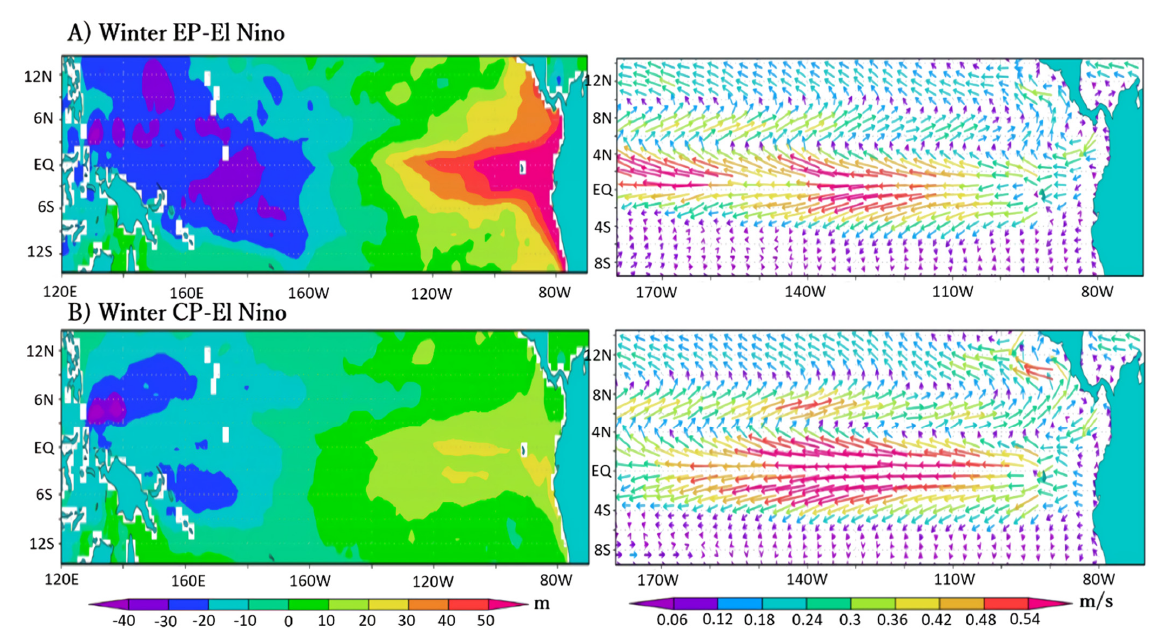
Figure 9. Composite maps of 20 °C isotherm depth (D20) anomalies (left panel) and ocean surface current (right panel) for the summer from ( A ) the EP El Niño and ( B ) CP El Niño. Negative (Positive) D20 anomalies denote shoaling (deepening).